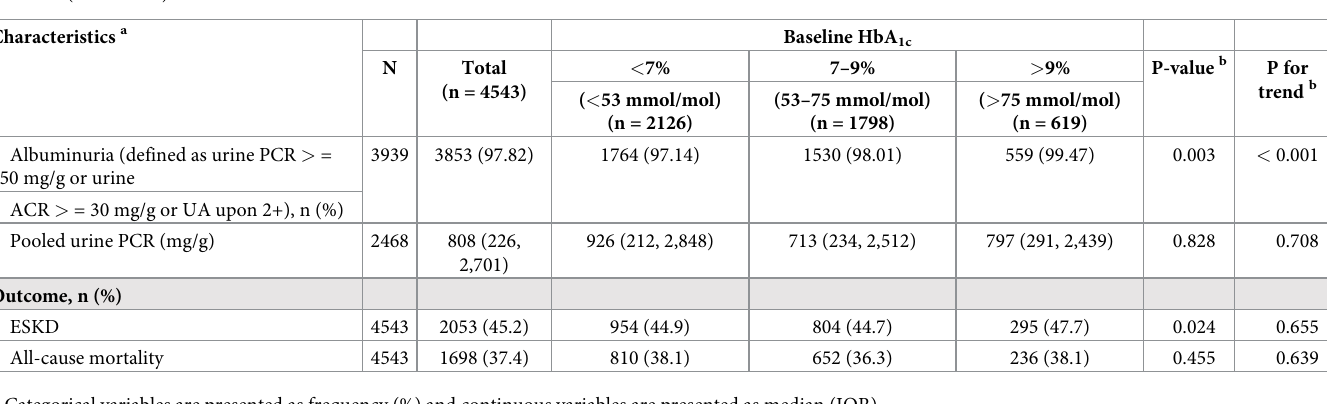
(9.9%) (Fig 2). The HbA trajectory of the “nearly-optimal” group was stably below a HbA 1c 1c level of 7% (53 mmol/mol), whereas the “moderate-to-stable” and “poorly controlled” groups had HbA trajectories that fluctuated at approximately 8% (64 mmol/mol) and 10% (86 1c mmol/mol), respectively. Both the “moderate-to-stable” and “poorly controlled” groups had downward trends in HbA levels during the follow-up, particularly in the case of the “poorly 1c controlled” group. Compared with the “nearly optimal” and “moderate-to-stable” groups, patients in the “poorly controlled” group—similar to those with baseline HbA levels of > 9% 1c ( > 75 mmol/mol)—were younger and tended to have longer follow-up for progression to ESKD and a higher BMI. Those patients were also less likely to have baseline CKD stage 4–5 with a corresponding higher eGFR at baseline (S1 Table). Deviating slightly from the observa- tions made in the baseline analysis, the proportion of patients with progression to ESKD was slightly higher in the “poorly controlled” group than in the other groups, whereas all-cause mortality was comparable among the three groups (S1